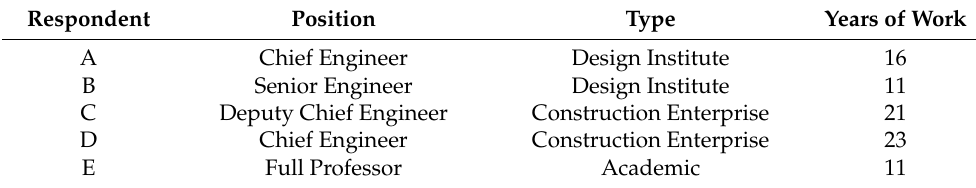
Table 5. Profiles of the